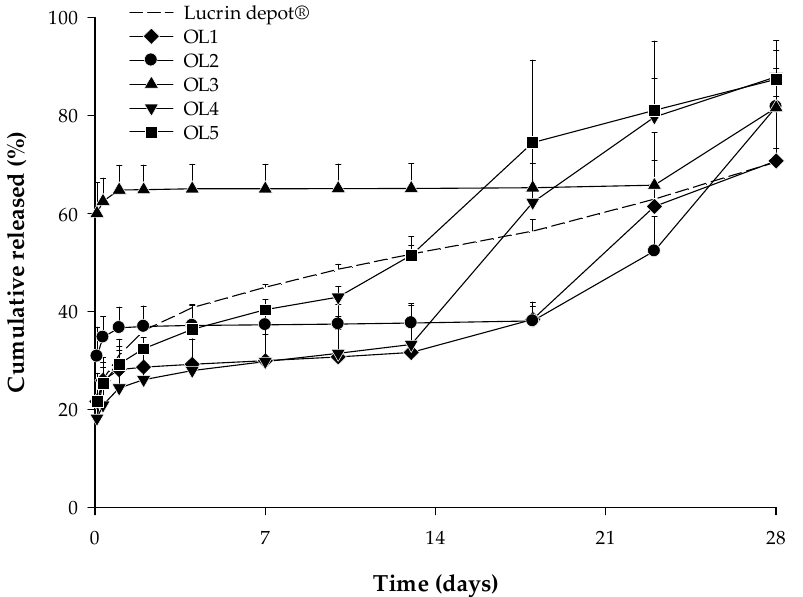
Figure 4. In vitro release profile for Lucrin depot ® and each trial formulation (OL1, OL2, OL3, OL4, and OL5) (mean ± SE, n = 3).